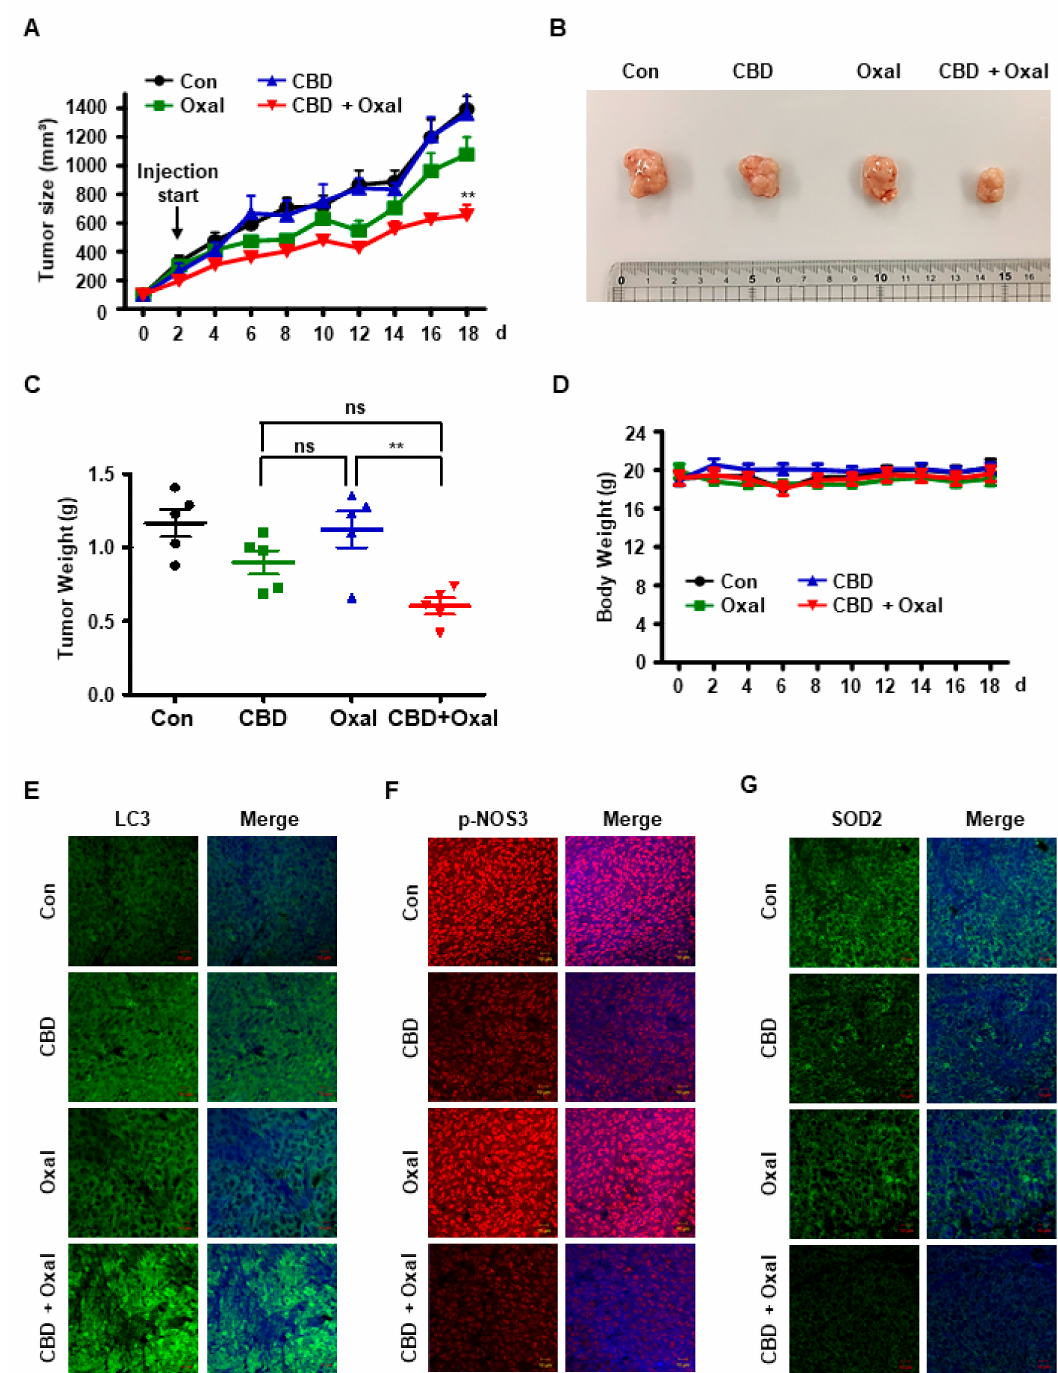
Figure 5. Oxaliplatin and CBD causes autophagy by downregulating phopho-NOS3 and SOD2 in vivo. ( A – D ) Nude BALB / c mice were subcutaneously injected with colo205 R cells and tumor growth and body weight were measured every 2 d after treatment with 5 mg / kg oxaliplatin, 10 mg / kg CBD, or their combination ( n = 5). The line graph indicates ( A ) tumor volume ( B ) and tumor tissues were imaged using a digital camera. After the experiment was terminated, ( C ) tumor tissue and ( D ) mice were weighed. **, p < 0.01. ( E – G ) Immunohistochemical staining was performed for ( E ) LC3, ( F ) phopho-NOS3, and ( G ) SOD2 on tumor sections isolated from xenografted mice (scale bar, 10 µ